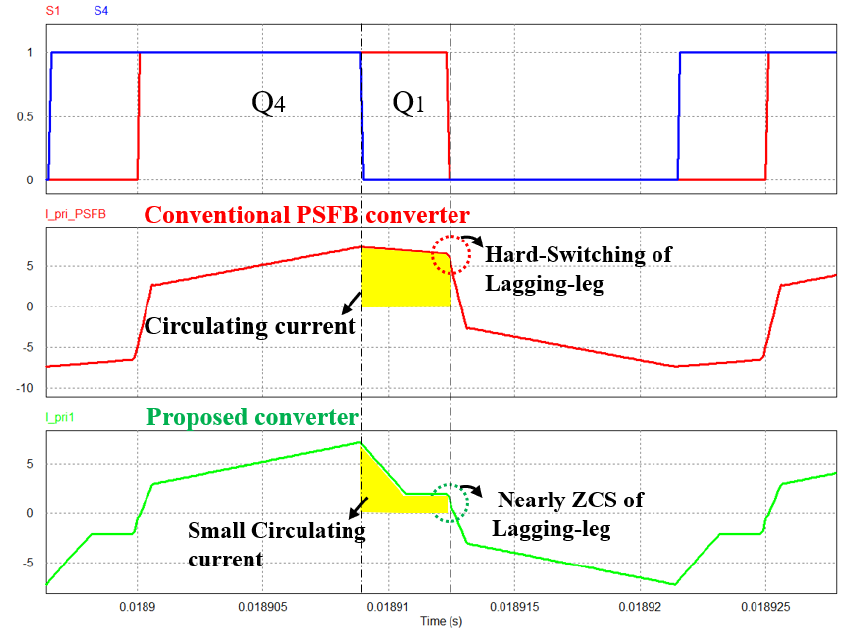
Figure 7. Comparison of the circulating current in the conventional PSFB converter and proposed converter.